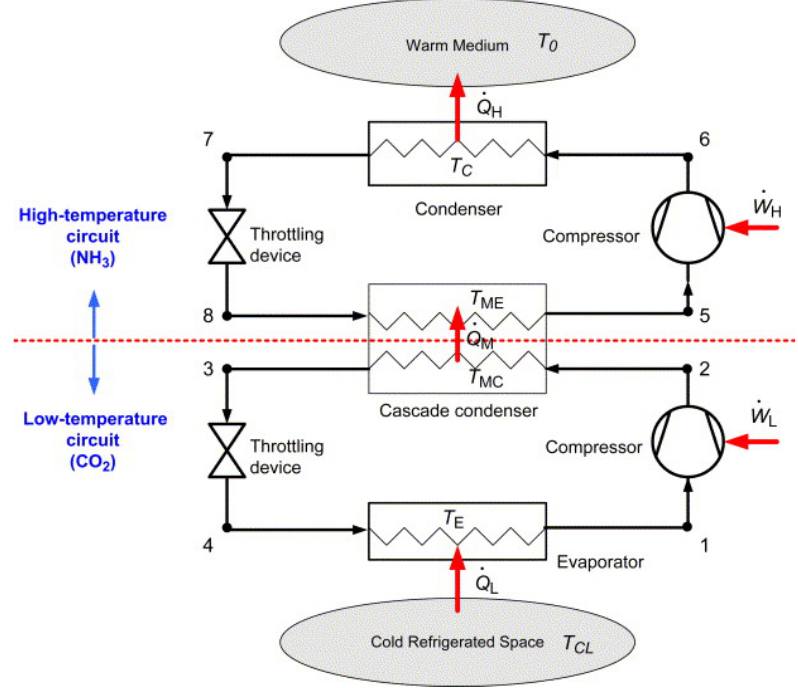
Figure 1. Schematic diagram of a CO 2 /NH 3 cascade refrigeration system [23]. Reproduced with permission from [Elsevier], Elsevier, 2020.